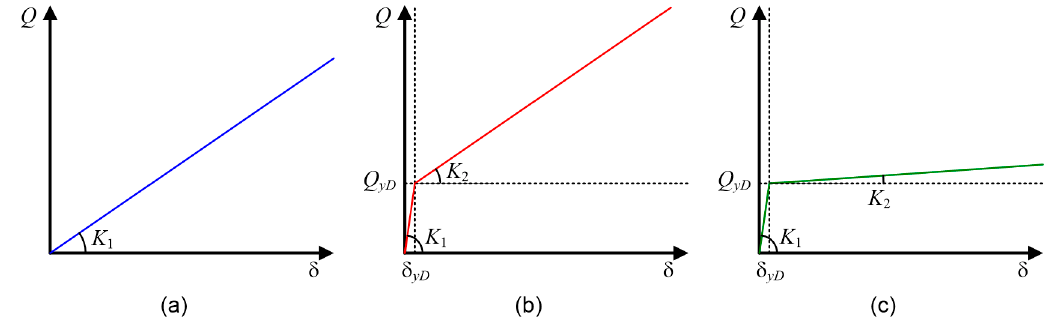
Figure 5. Force-deformation relationships for isolators and damper: ( a ) NRB, ( b ) LRB, and ( c ) steel damper.